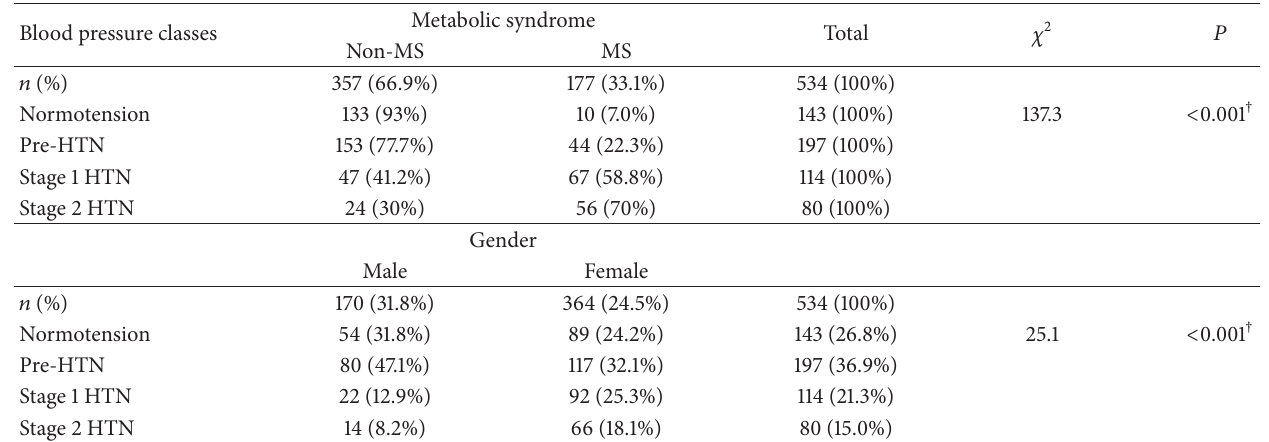
Table 1: Association of BP groups with gender and MS in traders.